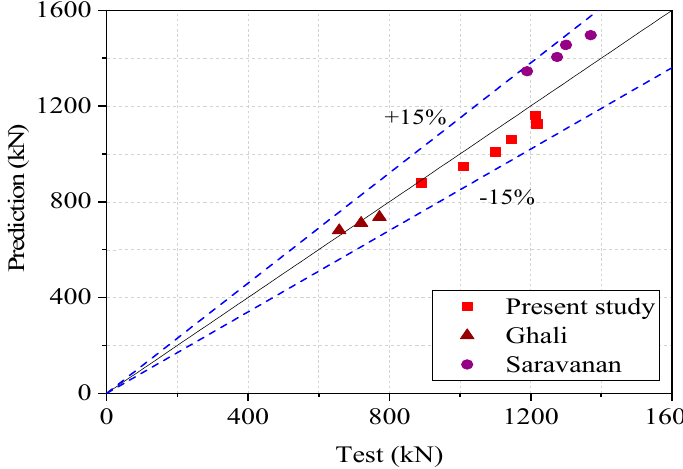
Figure 10. Prediction versus test ultimate load capacity.